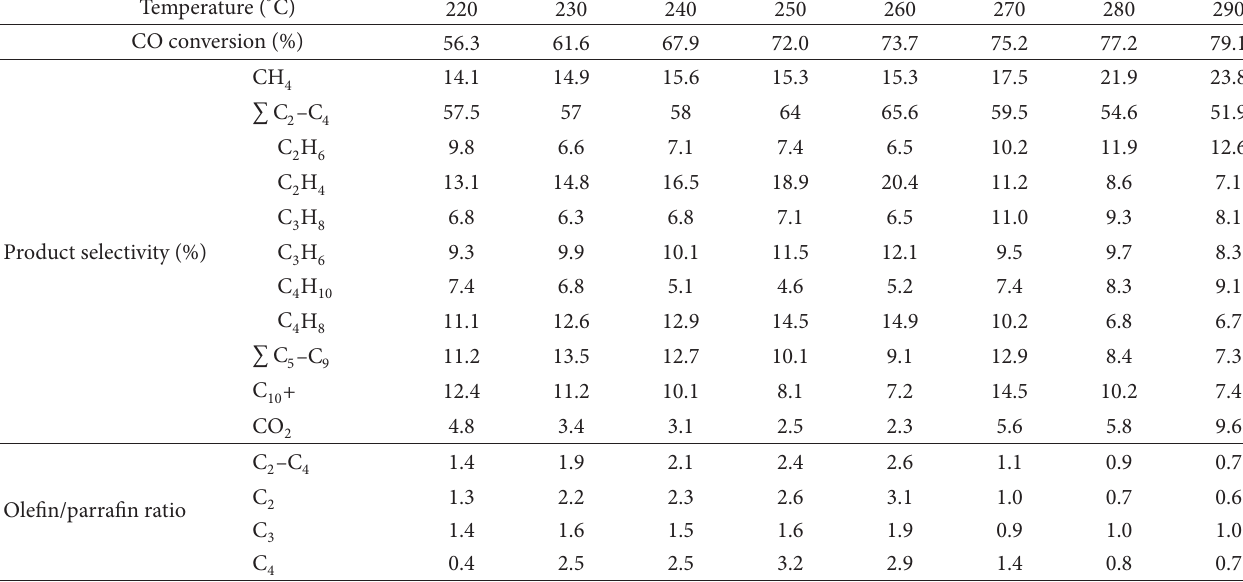
T 6: Effect of different reaction temperature on the catalytic performance of